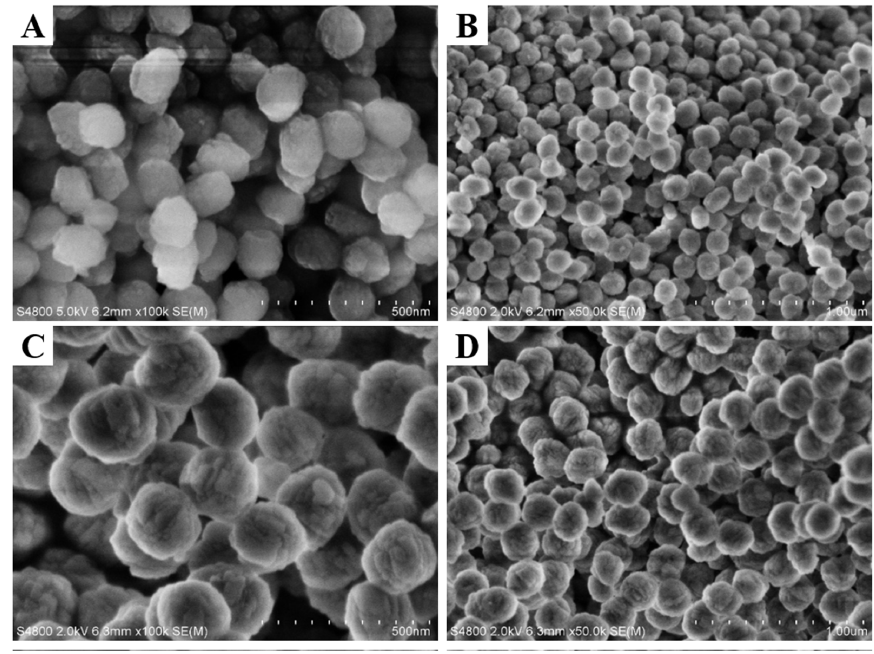
Figure 2. SEM images of Cu 1.1 @NS ( A , B ), Cu 2.1 @NS ( C , D ).